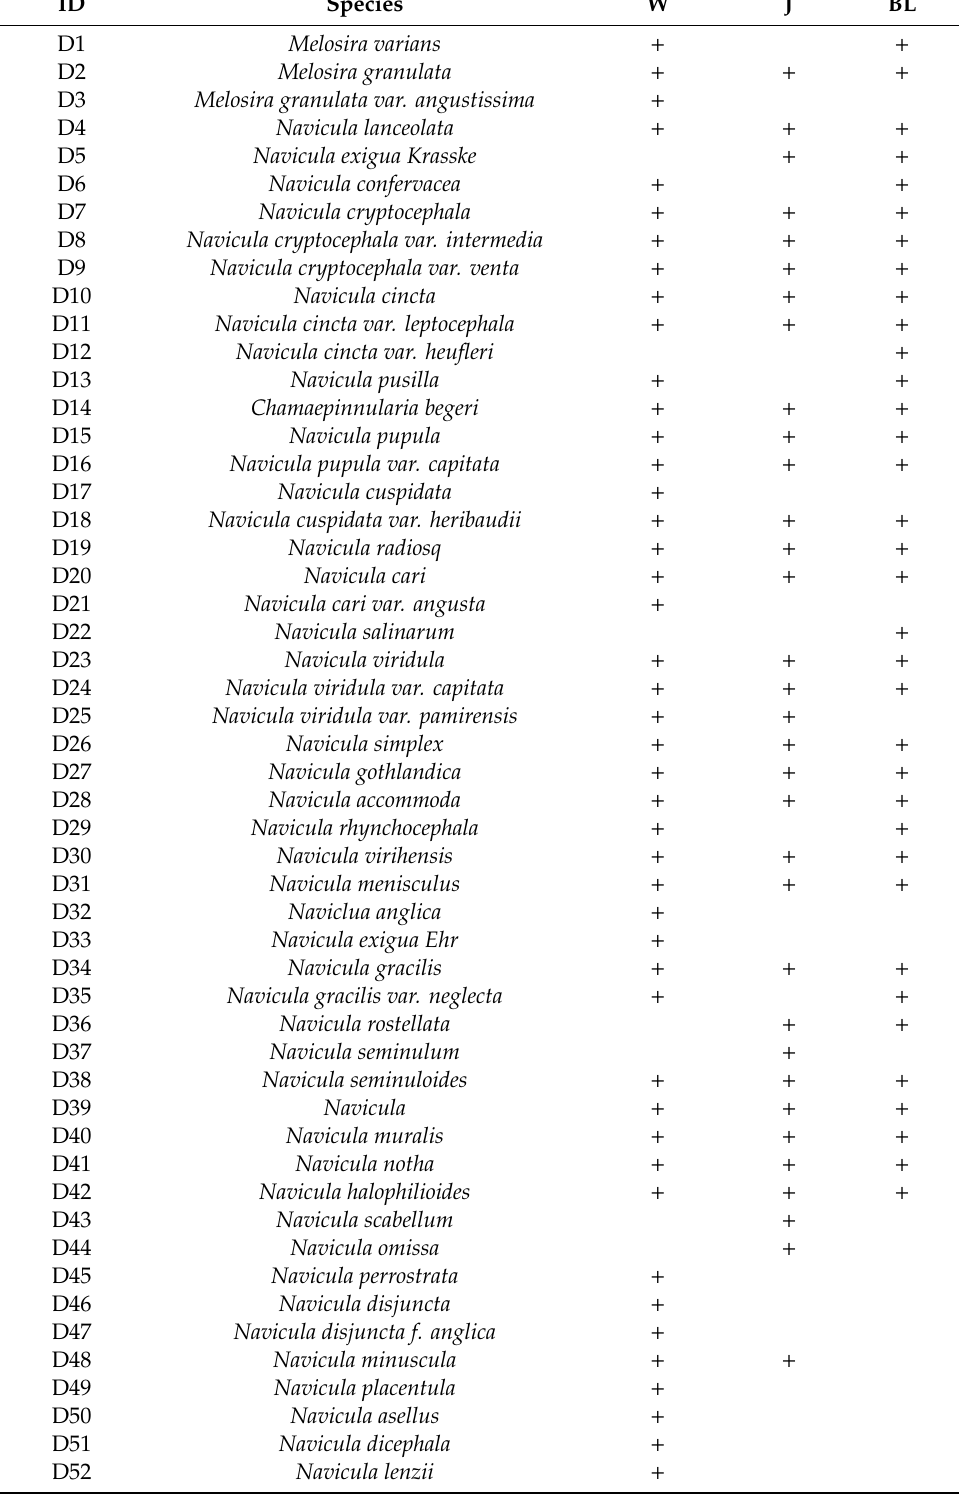
Table A1. The list of diatom species in Wei River